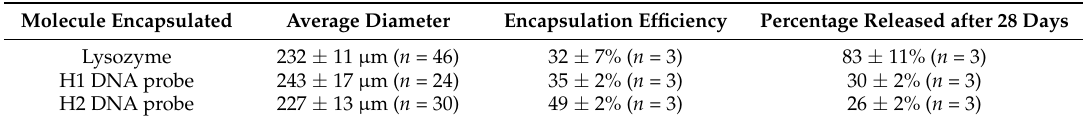
Table 1. Properties of biomolecule-releasing microspheres.